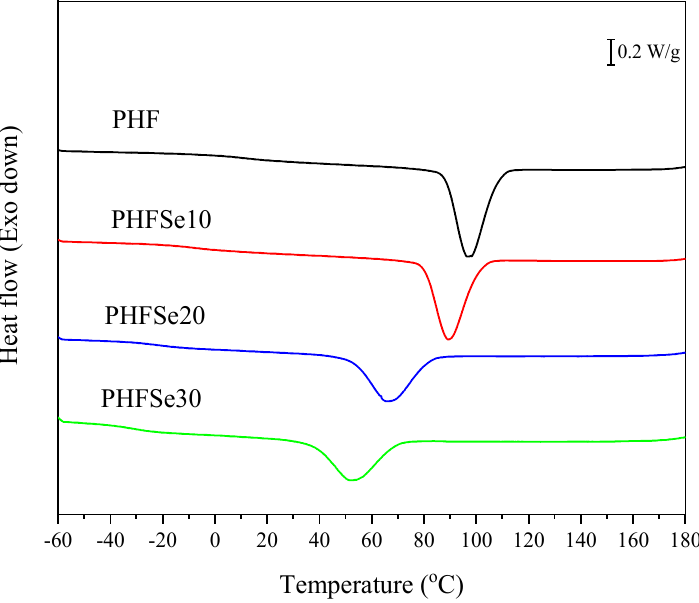
Figure 4. DSC cooling curves at 10 °C/min of PHF and PHFSe copolyesters. Table 2. Basic thermal behavior data of PHF and PHFSe copolyesters.